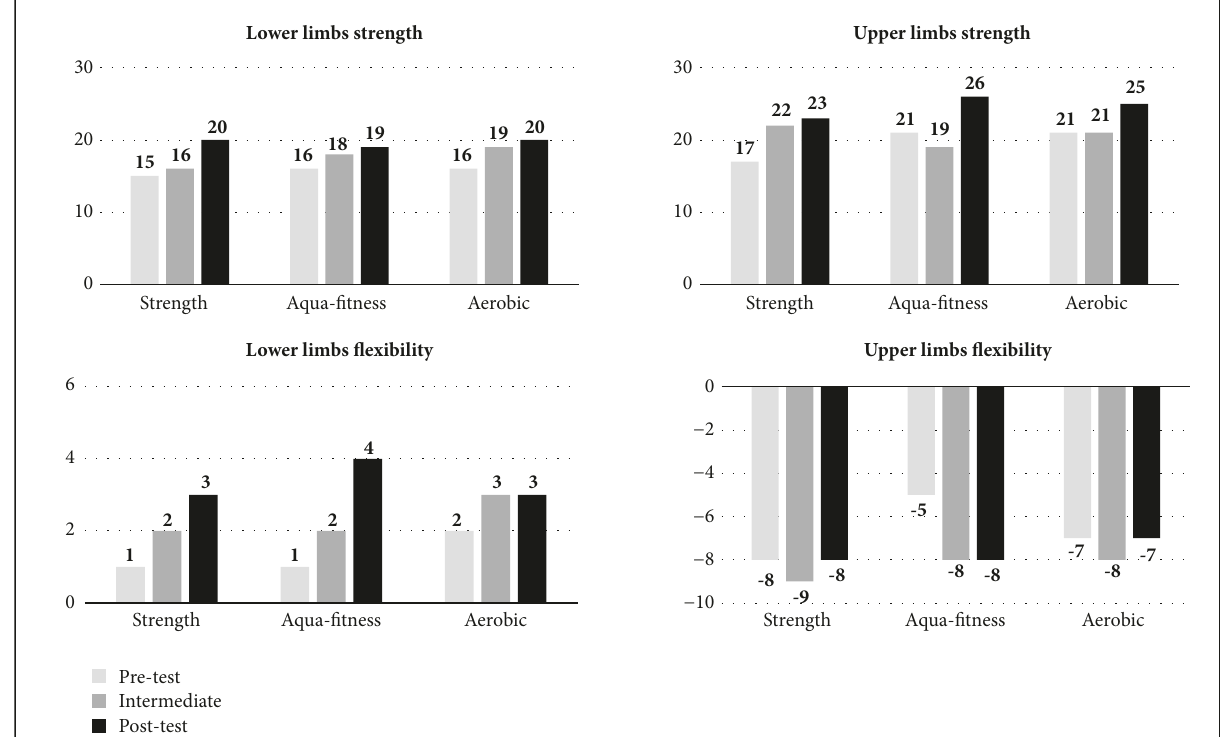
Figure 2: Senior Fitness Test women’s results by activity